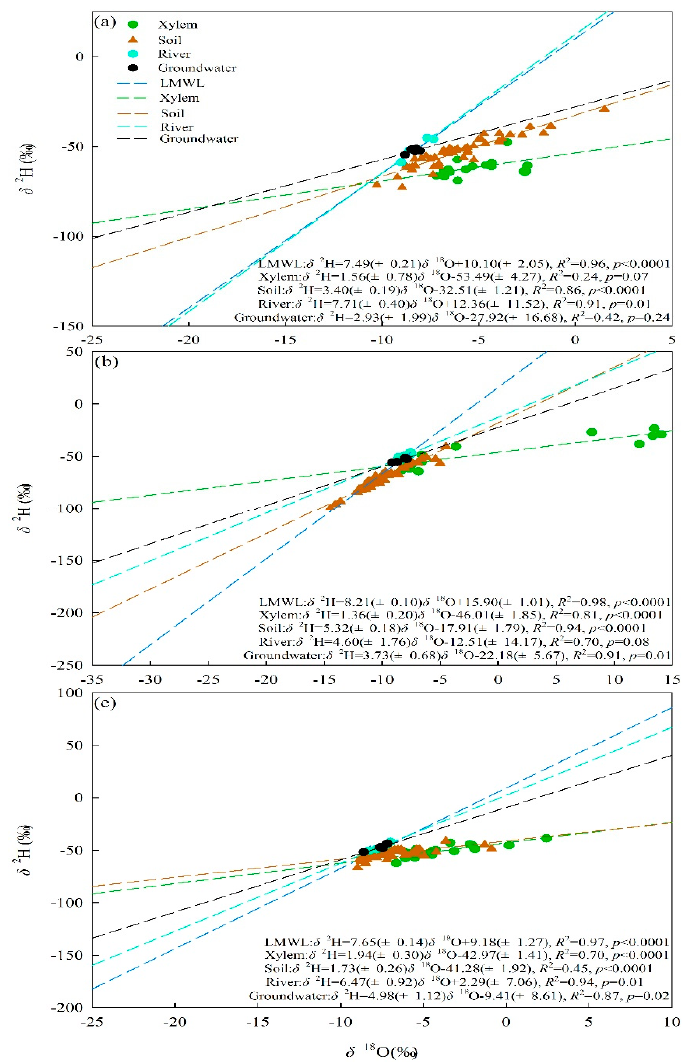
Figure 7. The linear relationship between δ 18 O and δ 2 H of the different water bodies sampled in ( a ) Gulang, ( b ) Wushaoling, and ( c ) Tianzhu. Table 9. Identification of the plant species collected in the Qilian Mountains in 2016.